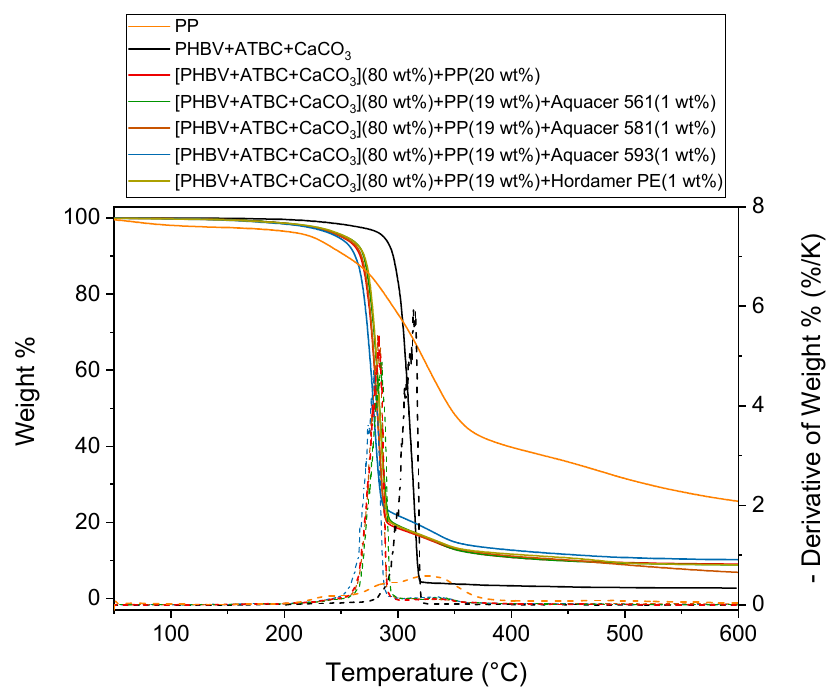
Figure 1. Thermogravimetric curves of the potato pulp powder (PP), the PHBV based matrix and biocomposite [PHBV(85 wt %) + ATBC(10 wt %) + CaCO 3 (5 wt %)](80 wt %) + PP(20 wt %) without and with wax treatment at 10 K/min under nitrogen flow (estimate error: ± 0.2 weight %). The dotted lines are the derivative of the weight % curves.